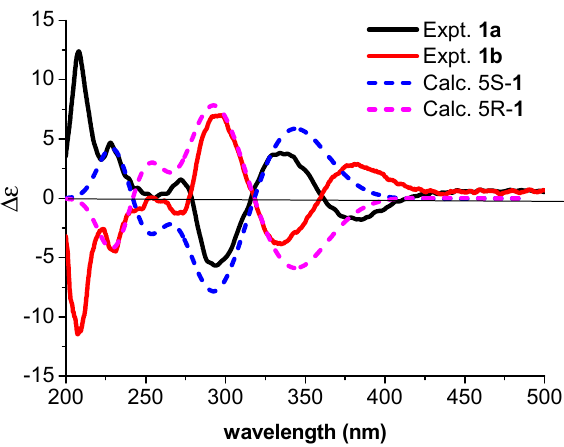
Figure 4. The experimental ECD spectra of 1a and 1b and calculated ECD spectra for (5 S )- 1 and (5 R )- 1 (UV correction = − 10 nm, band width σ = 0.3 eV).